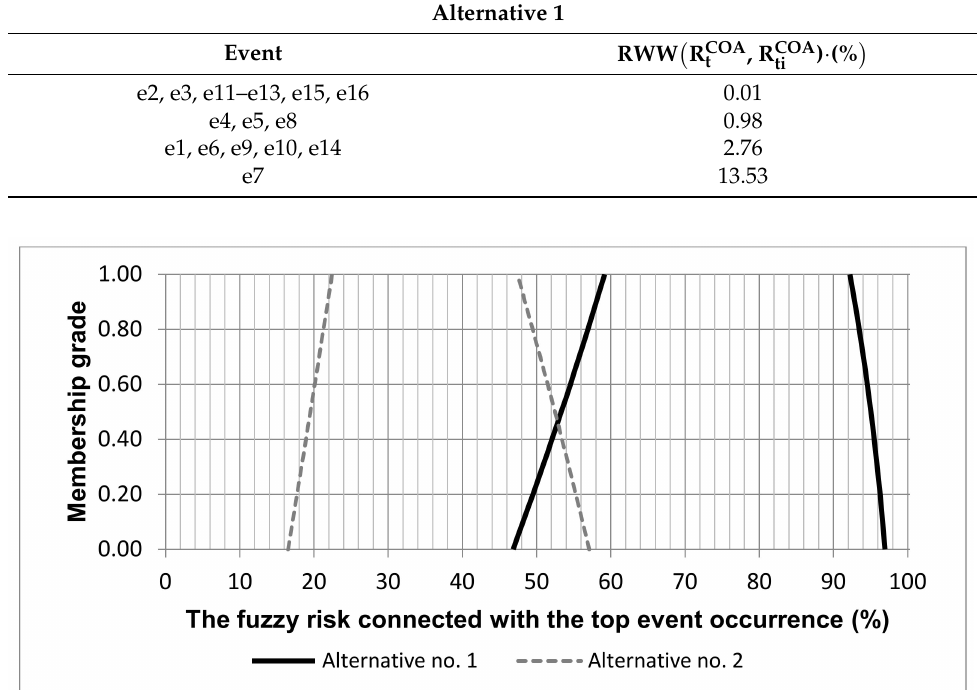
Figure 4. Distribution of the fuzzy risk of the TE occurrence for the analyzed passive building project for two configurations of risk management